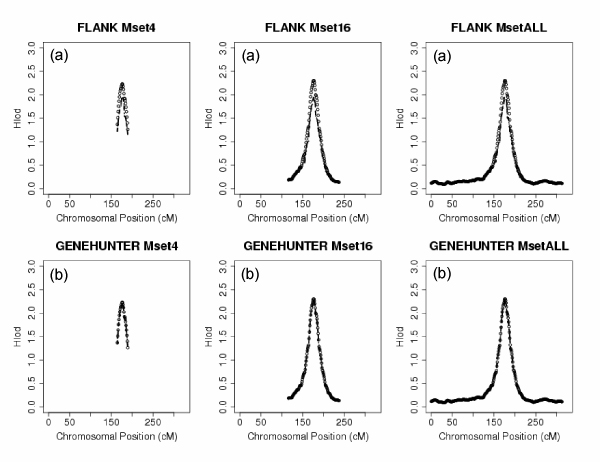
Comparison of mean HLOD scores calculated using CHROM-WALK and GENEHUNTER on chromosome 1 data. Mean HLOD scores, calculated using CHROM-WALK (a) and GENEHUNTER (b) on chromosome 1 data. Circles represent GENEHUNTER HLOD scores, calculated on data with no missing data. The dashed line represents the HLOD score curve calculated on data with 1% missing data and 0.5% Mendelian consistent genotyping error.